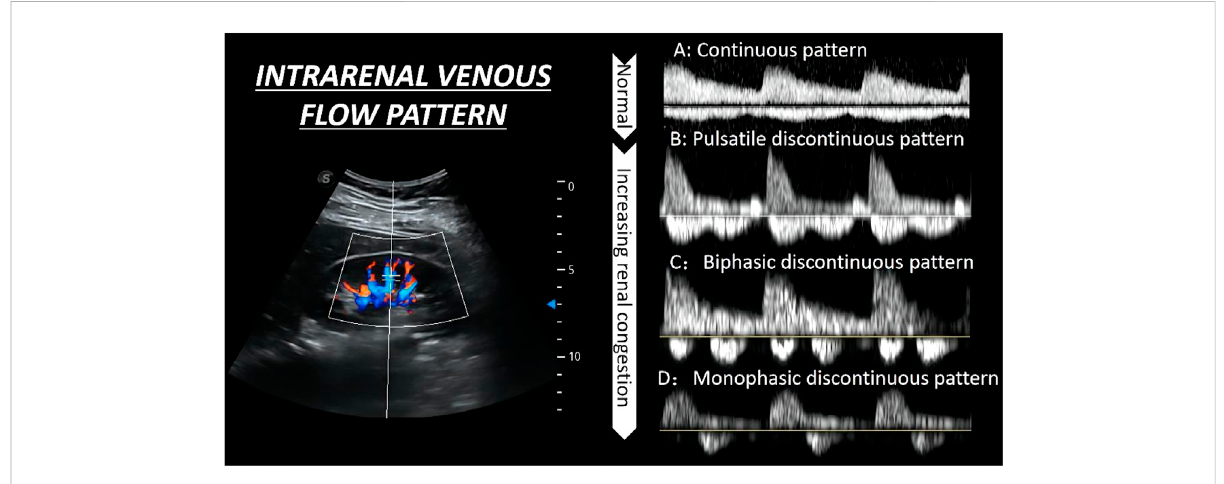
ThequalitativeevaluationofrenalhemodynamicsbypulsewaveDopplerintheinterlobarvesselsoftherightkidney.Thewaveformchangesare divided into four fl ow patterns from (A – D)